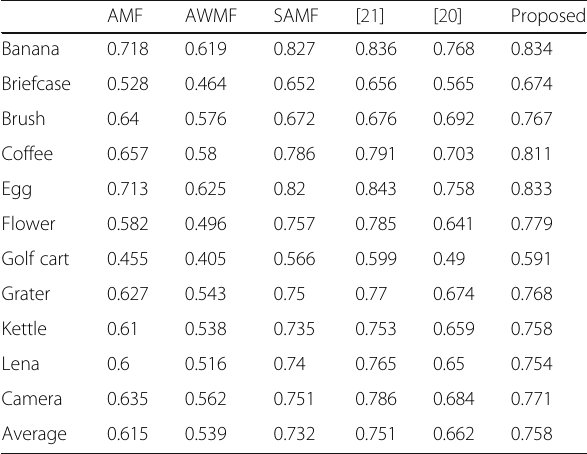
Table 9 MSSIM comparison for 90% noise